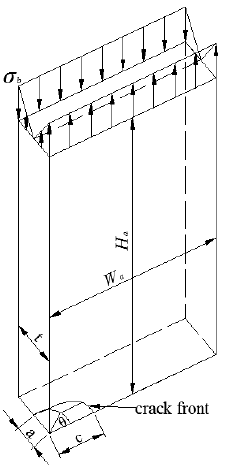
Figure 9. One-quarter model for the semi-elliptical crack in a rectangular plate.